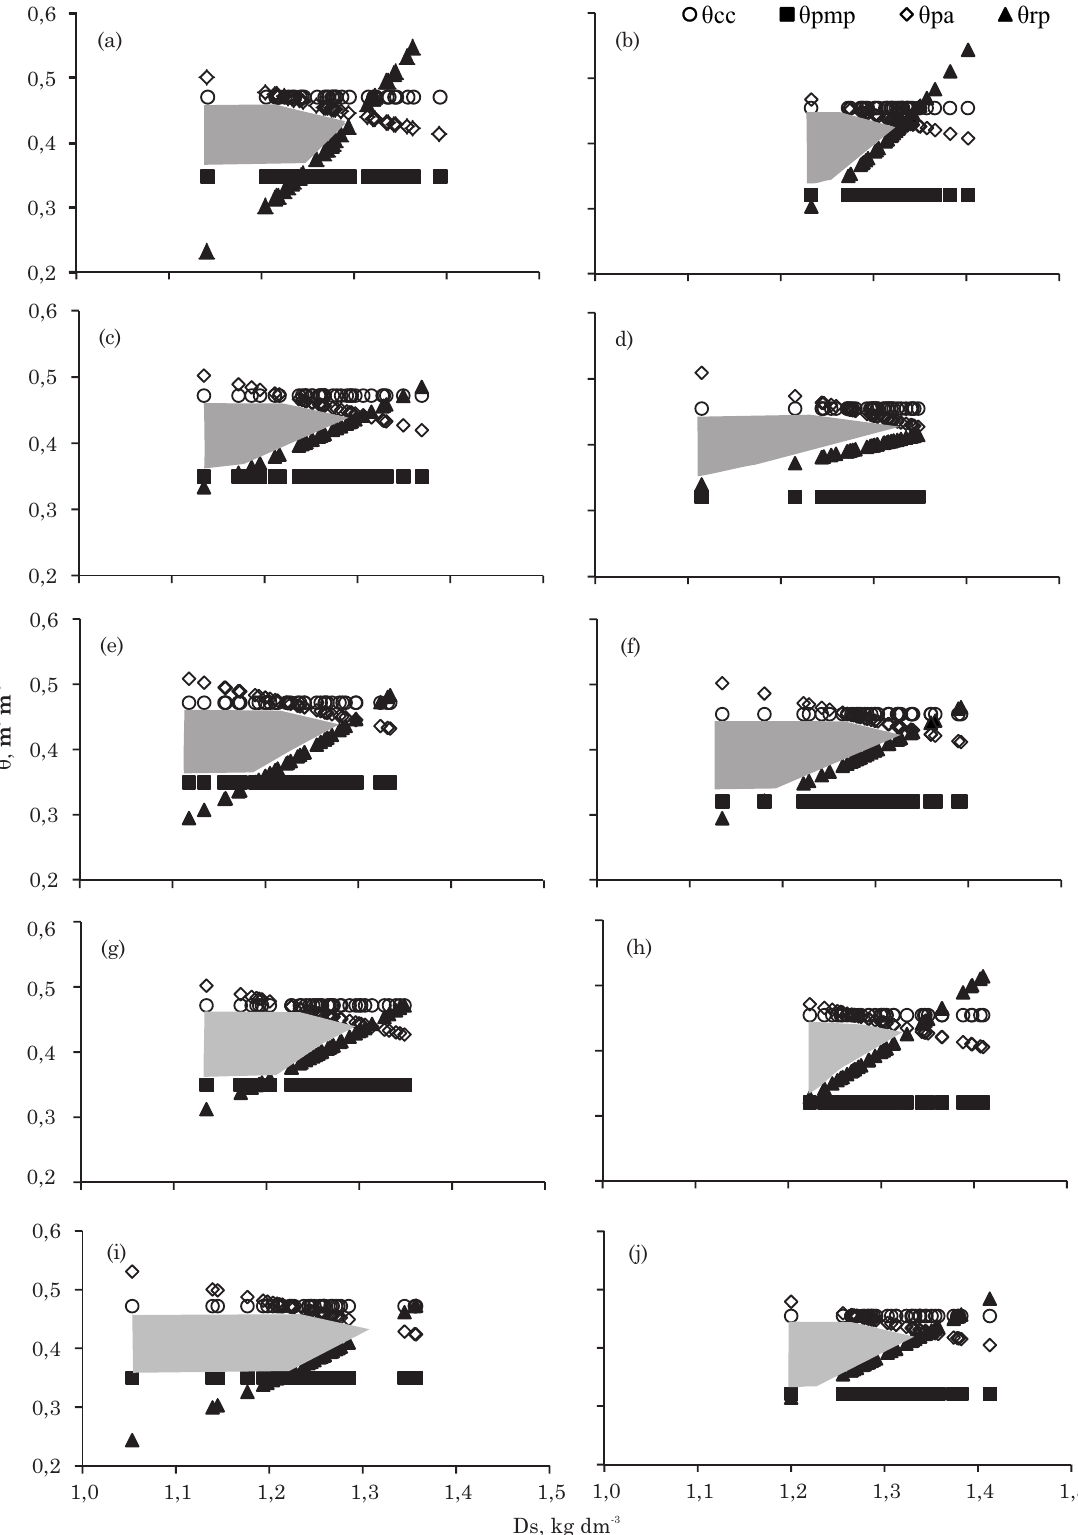
Figura 4. Variação do teor de água ( θθθθθ ) com a densidade do solo (Ds) nos níveis críticos da capacidade de campo ( θθθθθ CC ), ponto de murcha permanente ( θθθθθ PMP ), resistência à penetração ( θθθθθ RP ) e porosidade de aeração ( θθθθθ PA ) nos tratamentos de 7 cm (a, b), 14 cm (c, d), 21 cm (e, f), 28 cm (g, h) e testemunha (i, j), nas profundidades de 0,0-7,5 (a, c, e, g, i) e 7,5-15,0 cm (b, d, f, h, j). As áreas em cinza correspondem ao